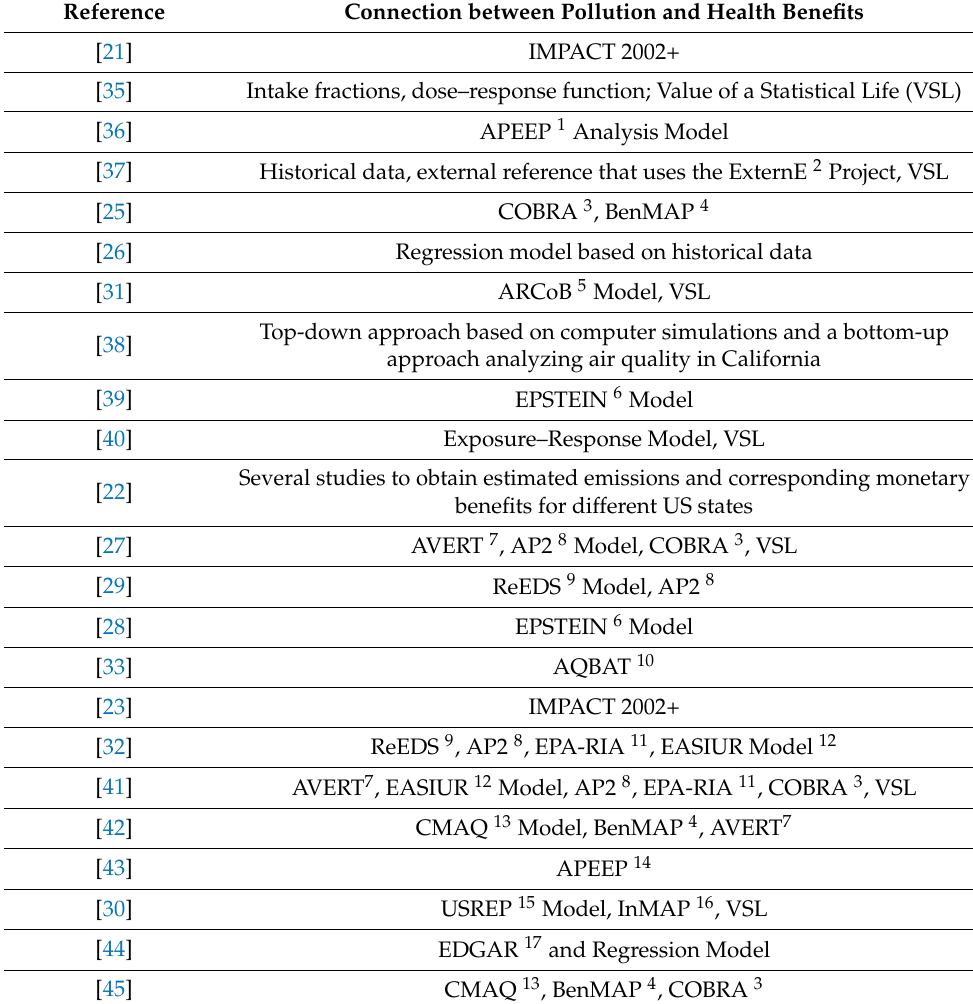
Table 5. Approaches used to estimate health